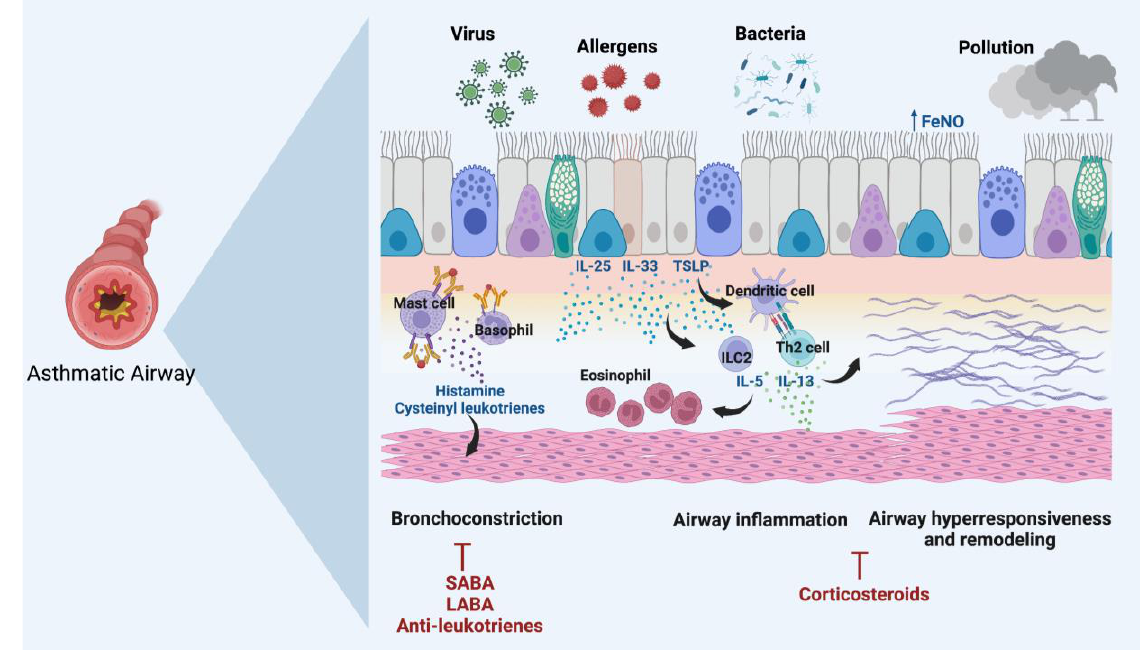
Figure 1. Pathophysiology of asthma. Alarmin cytokines IL-25, IL-33 and TSLP are released from the airway epithelium in response to external stimuli such as pathogens, allergens, and pollution. These cytokines result in the downstream production of type 2 cytokines (IL-4, IL-5, and IL-13) from Th2 cells and their innate counterpart, ILC2s. The type 2 cytokines induce airway inflammation, FeNO, airway hyperresponsiveness, and remodeling, all inhibited by corticosteroids. The production of histamine and leukotrienes from activated basophils and mast cells promotes bronchoconstriction, which is prevented by antagonists. FeNO = fractional exhaled nitric oxide; LABA = long acting β -agonist; SABA = short- acting β -agonis.